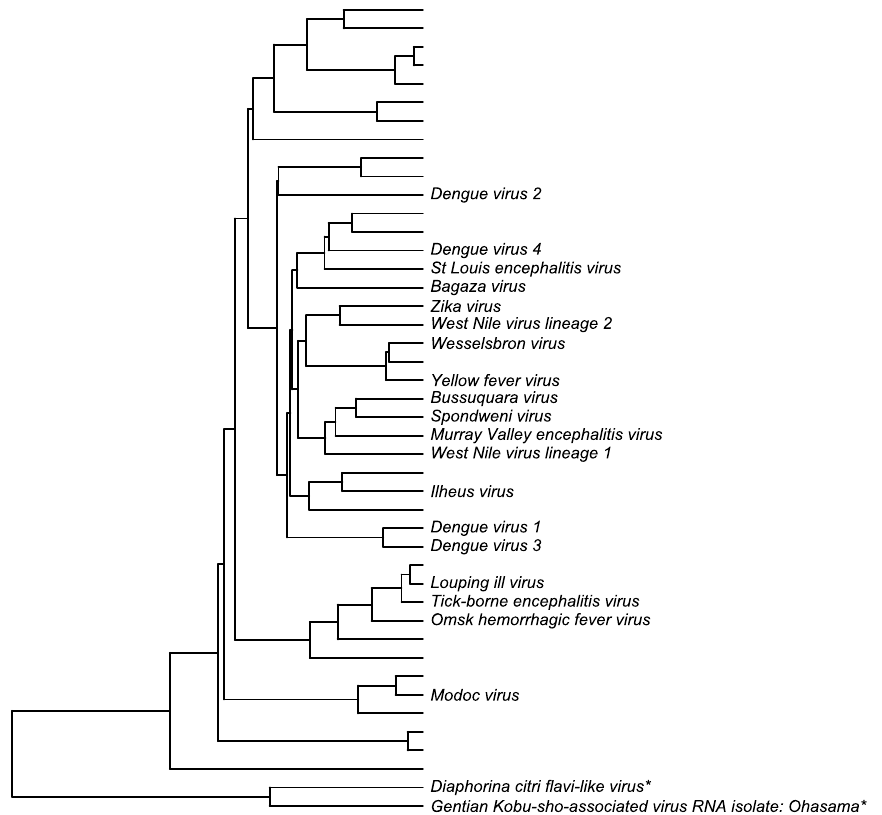
Fig 6. Dendrogram of cluster 32, which corresponds to the Flaviviruses. Of the 44 viruses in this cluster, 19 which are clinically significant in humans are labeled; taxa names for the other 25 are omitted for clarity. This constructed phylogeny suggests that Zika is more genetically similar to the West Nile virus and yellow fever than to the Dengue viruses; the closest Dengue virus is Dengue 4. The two species marked with asterisks are not Flaviviruses; although they were clustered together with them, they are separated from the true Flaviviruses. Eight Flaviviruses make up a single sub-cluster of cluster 16 instead.